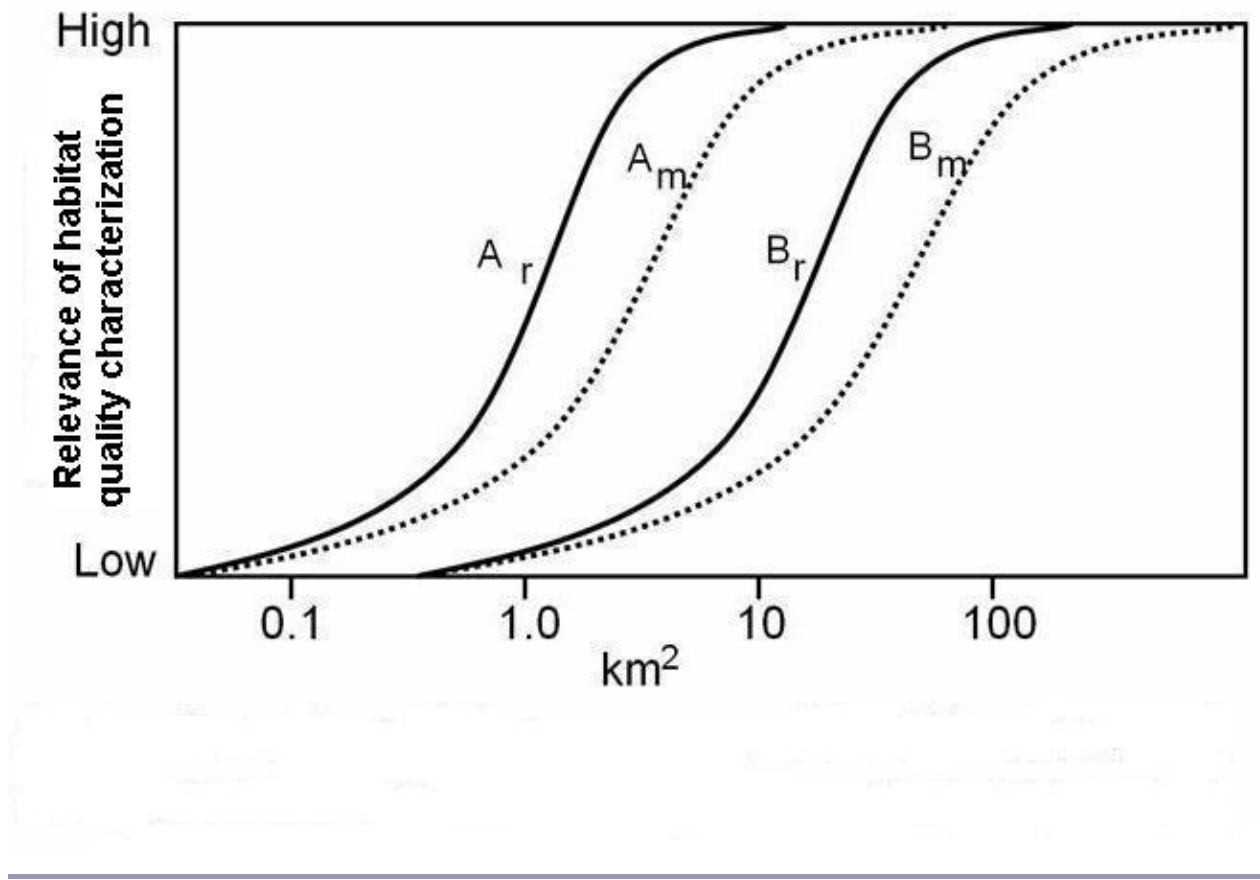
Fig. 1 . Generalized relationship of the relevance of characterizing habitat quality in an ecological risk assessment vs. the size of the site, taking into account the home range and residency status of the assessment species. A represents a resident species with a small range; A , a migrant species with a small range; B r m a resident species with a large range; and B , a migrant species with a large m